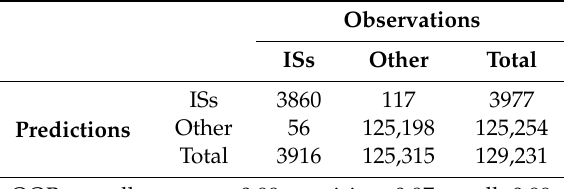
Table 5. Confusion matrix for the random forests classification map assessed by validation samples. Ground Reference ISs Other Total Classification